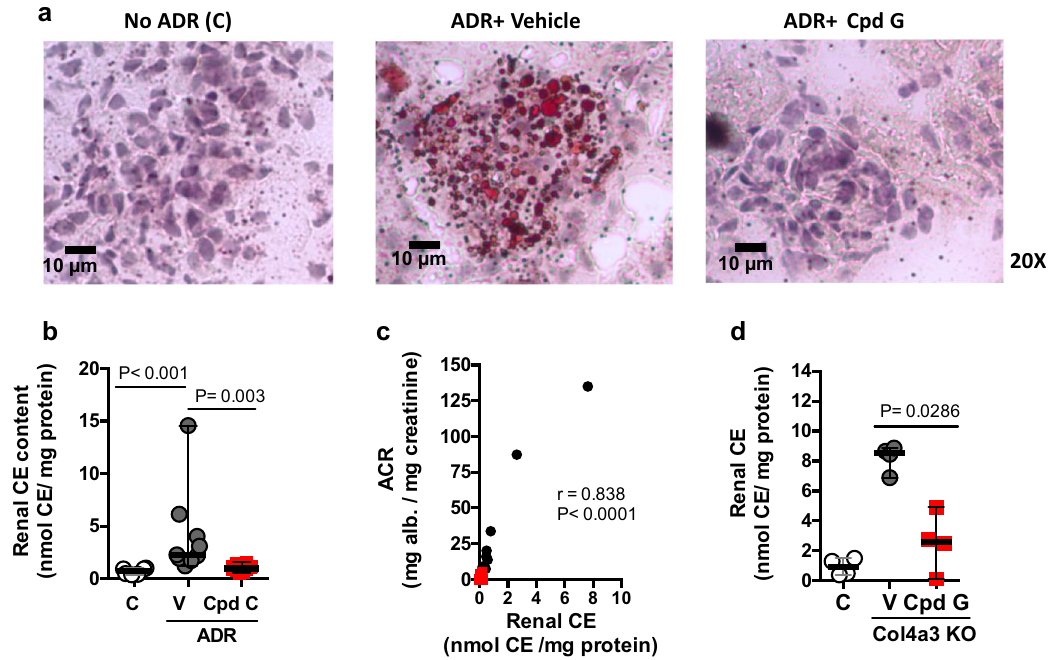
Fig. 8 Cpd G reduced accumulation of cholesterol esters in renal cortex in both disease models. a – c Lipid accumulation in kidneys from mice that received vehicle (V, n = 8) or Cpd G ( n = 10) for 28 days after ADR challenge. A group that did not receive ADR (C) ( n = 10), is included to show the healthy phenotype. a Representative image of Oil-red O (ORO) stained kidney sections; b cholesterol ester (CE) content, normalized to total proteins in kidneys. Data expressed as the median and range. Differences with regard to animals injected with ADR that received vehicle were calculated using Kruskal – Wallis, followed by Dunn ’ s test: no ADR, P < 0.001; ADR + Cpd G, P = 0.003; c cholesterol ester content in kidneys from individual animals vs the corresponding albuminuria (ACR) values at day 28 of treatment. The data points in red correspond to the group that received Cpd G. A two-tailed Spearman correlation coef fi cient test was used to assess the relationship between the variables ( n = 17 pairs, r = 0.838, P < 0.0001). d Cholesterol ester content (CE), normalized to total proteins, in the kidney cortexes from 8-week-old Col4a3 KO mice, that received vehicle or Cpd G for 28 days. A group of Col4a3 + / + littermates of the same age (C), is included to show the healthy phenotype. Data expressed as the median and range. Col4a3 KO mice treated with vehicle or with Cpd G were compared using a double-tailed Mann – Whitney test ( n = 4, U = 0, P =